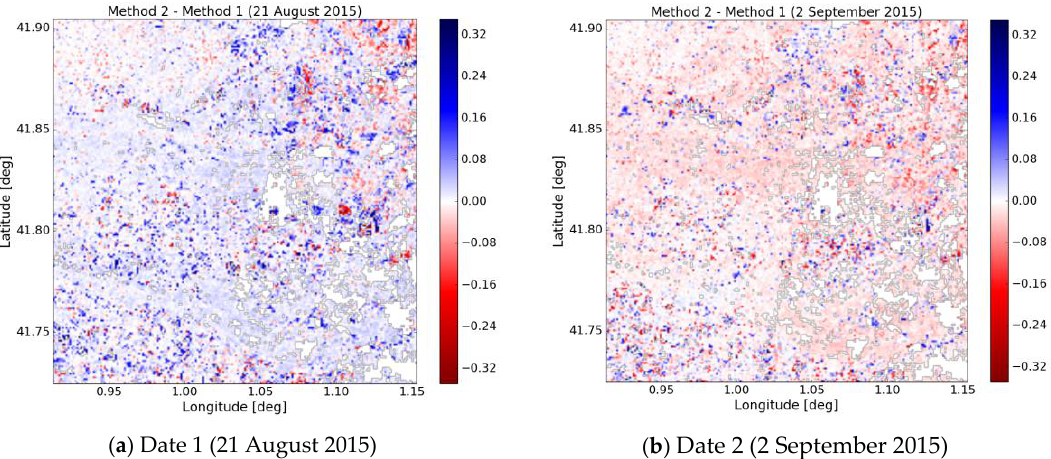
Figure 13. Difference of soil moisture retrieved by method 2 and 1 for date 1 (21 August 2015) and date 2 ( 2 September 2015 ).